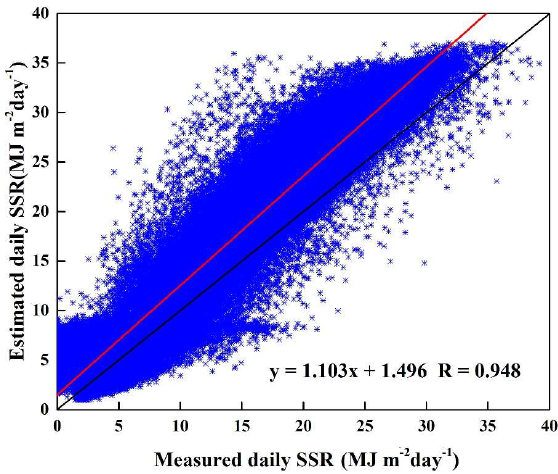
Figure 9. Validation of the estimated SSR values by the YHM algorithm at 96 CMA radiation stations during 2002–2014.